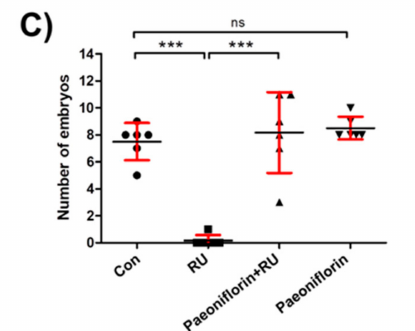
Figure 2. Paeoniflorin enhanced embryo implantation in mifepristone (RU486)-induced implantation failure mouse model. ( A ) Female mice were administered paeoniflorin (8 mg · kg − 1 · day − 1 ) for 17 days. Seven days after paeoniflorin administration, female mice were mated with males. On day 4 from pregnancy, evidenced by vaginal plugs, female mice were daily treated with RU (4 mg · kg − 1 · day − 1 ) by subcutaneous injection for 4 days. ( B ) Seven days after RU injections, mice were euthanized and the uteri were excised. Representative image of an embryo-implanted uterus is shown. Uterine tissue sections were stained with hematoxylin and eosin (H&E) and histologically analyzed. ( C ) The number of embryo implantation sites was counted and is expressed as the mean ± standard error of the mean (SEM); *** p < 0.001 compared to other groups; ns, no significance.